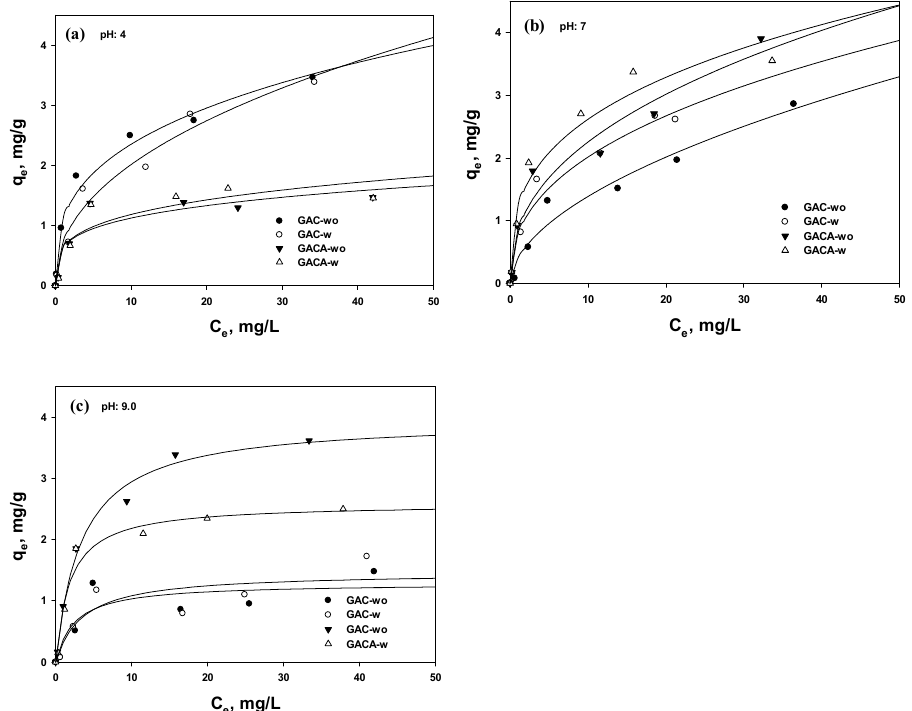
Figure 5. Freundlich isotherm for GAC and GACA with/without pH adjustment at initial pH of 4 ( a ), 7 ( b ), and 9 ( c ).